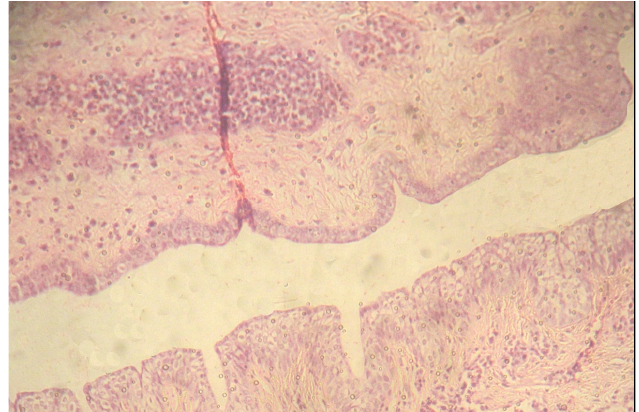
Source: research protocol